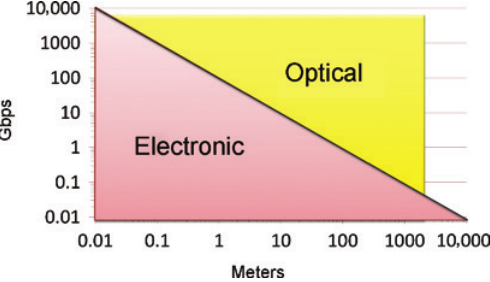
Figure 2: Bandwidth-distance limits of electronic communication.